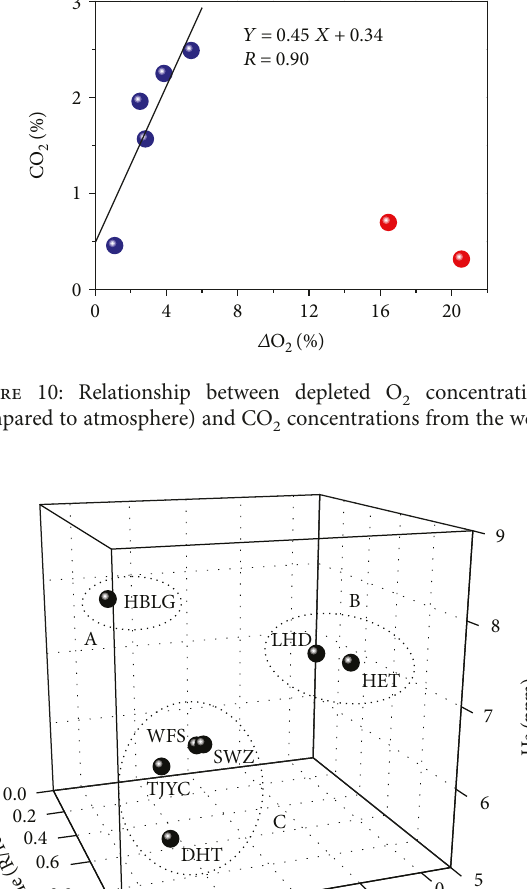
Figure 11: Relationship between 3 He/ 4 He and the average values of concentration and He concentration of soil gas. Red dots: CO 2 values for wells DHT, HBLG, and WFS. Blue dots: values for wells TJYC, LHD, HET, and SWZ.